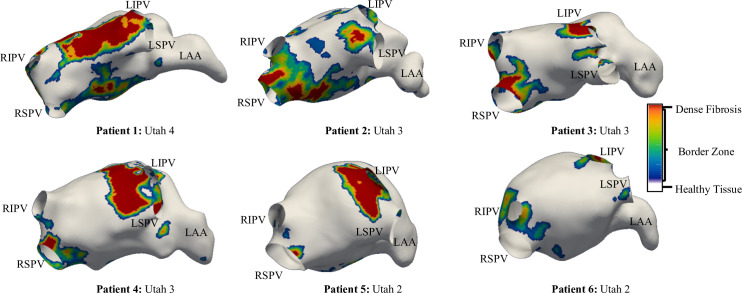
Patient-specific fibrosis distribution in 6 AF patients with Utah scores from 2 to 4.The fibrotic regions are colour-coded to show dense fibrotic tissue (red) surrounded by a BZ of intermediate properties. The healthy atrium is shown in white. LIPV: left Inferior PV, RIPV: Right Inferior PV, LSPV: left Superior PV, RSPV: Right Superior PV and LAA: Left Atrial Appendage.